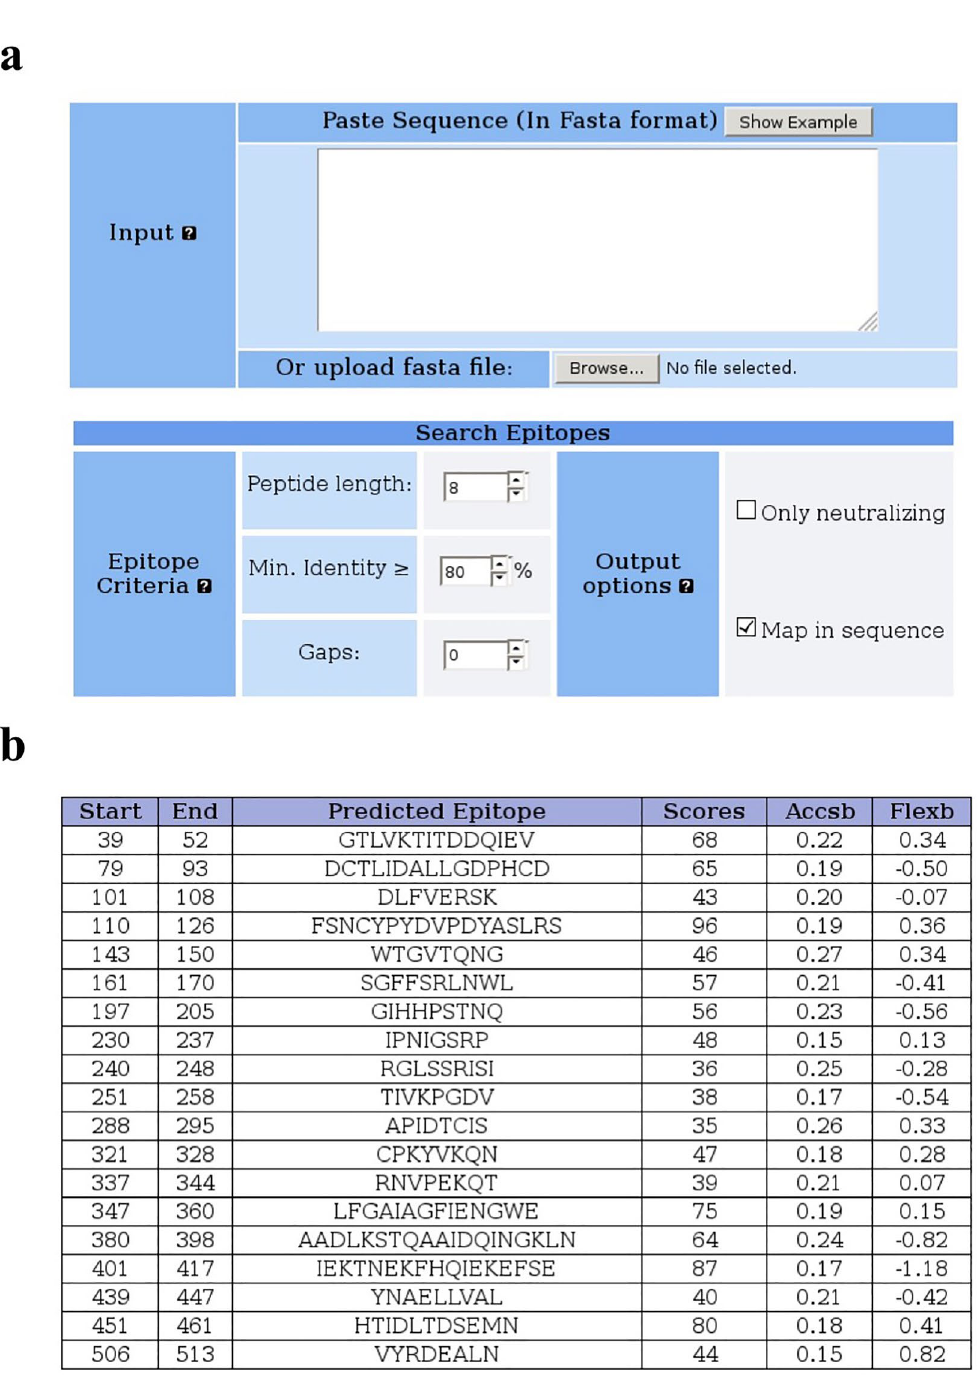
Figure 2. BepiBlast web server. ( a ) BepiBlast interface. ( b ) Representative BepiBlast output obtained with default settings. The shown results were obtained for hemagglutinin from Influenza A virus (UniProt Id: P03437). BepiBlast main result consists of a table displaying the following information (from left to right): peptide starting position; peptide ending position; predicted B cell epitope; bit score; accessibility value and flexibility